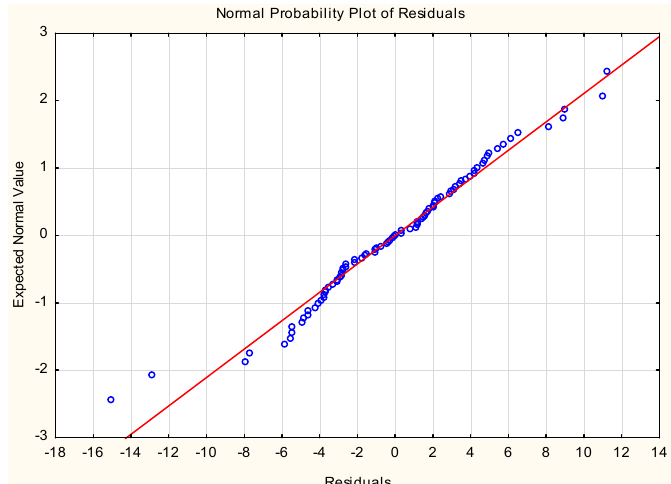
Fig. 2: Normal credibility plot of residuals of the piecewise linear regression model